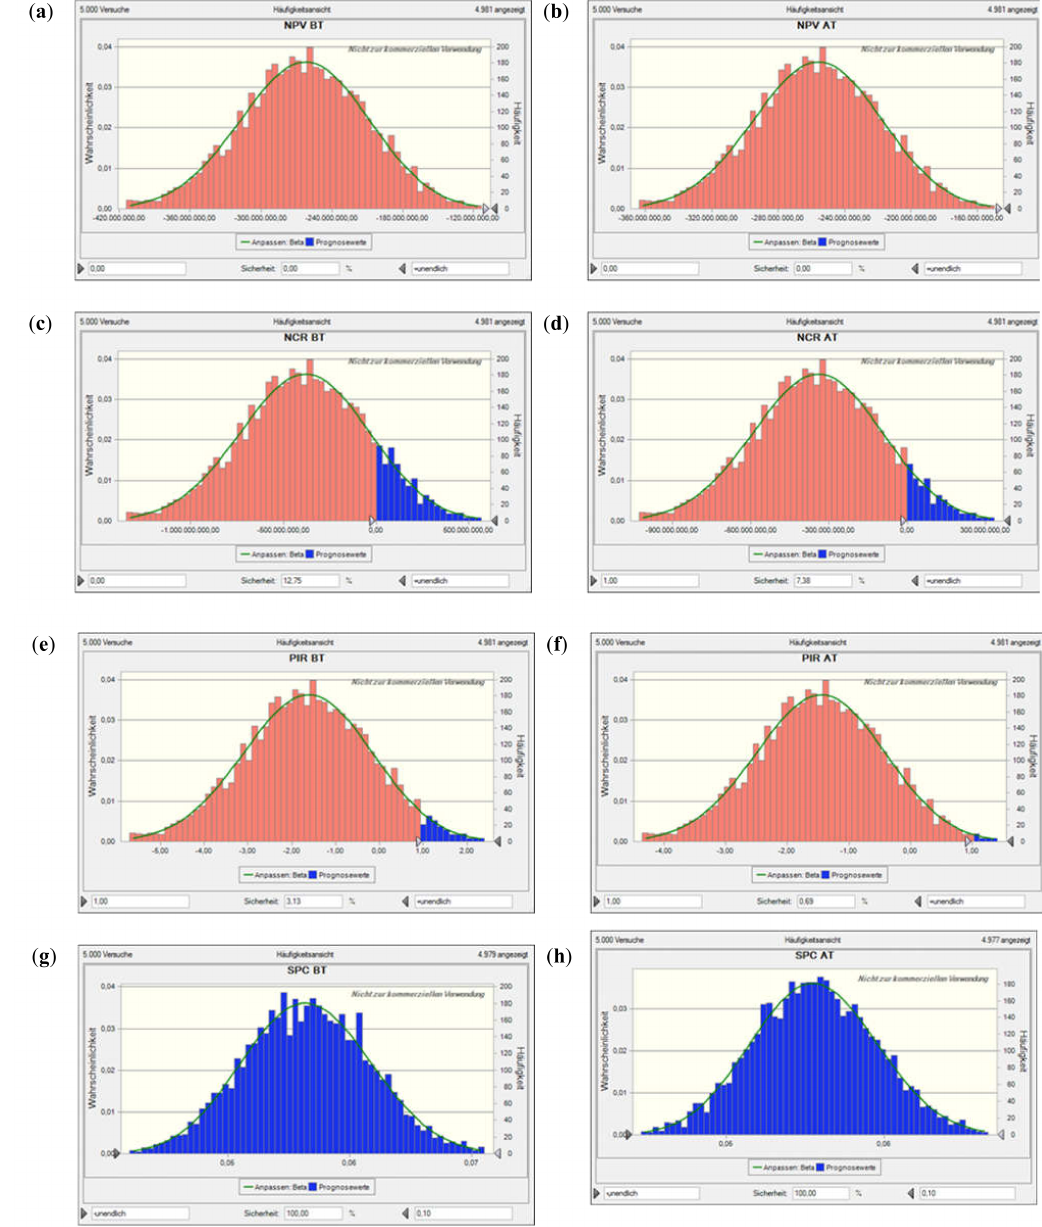
Figure A5. Value at risk for Scen. 1, incl. flooding time, based on a monte Carlo simulation with 5000 runs. Plots ( a ) and ( b ) show the net present value (NPV) before and after tax, plots ( c ) and ( d ) the NCR before and after tax, plots ( e ) and ( f ) the profit-to-investment ratio (PIR) before and after tax, and plots ( g ) and ( h ) the per unit (specific) production costs (SPC) before and after tax. The solid lines denote the fitted probability distribution, the red areas the confidence interval of not encountering a neg. NPV, neg. NCR, or PIR < 1 (i.e., depending on the performance indicator concerned; as the costs considered are all positive, there is only a blue histogram in those two